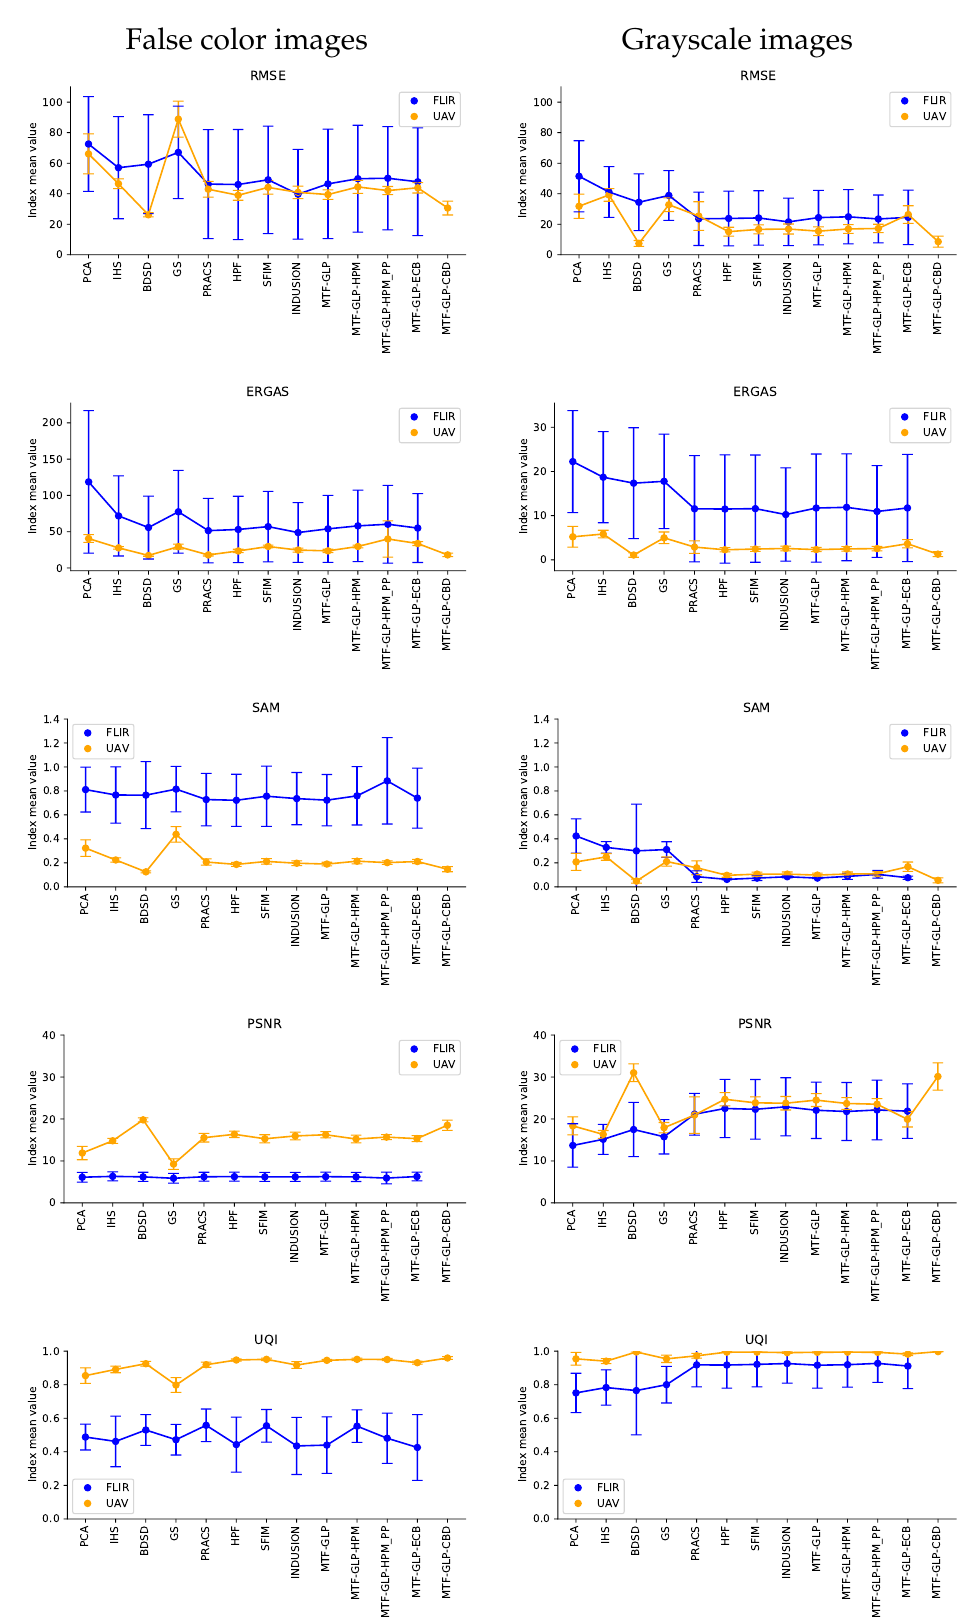
Figure 2. Graphic representation of computed quality indices. The different indices have been categorized in false color and grayscale. Dots represent quality index value, and vertical line length shows sample standard deviations. Graphics in ERGAS row are not directy comparable due to different y-axis